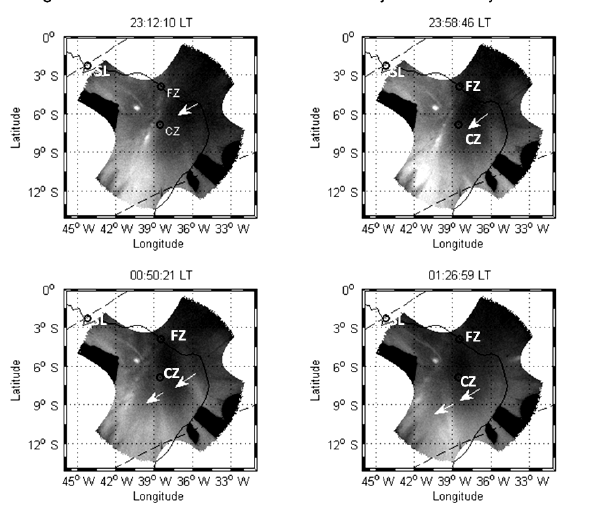
Figure 3. Sequence of OI 630nm images showing the time evolu- tion of depletions on 25–26 July 2011 between 23:12 and 01:26LT at Cajazeiras, Brazil. The images are projected onto geographic co- ordinates over the Brazil map. In the plot, FZ is Fortaleza, SL is São Luís, and CZ is Cajazeiras. Arrows indicate the propagation direction of the depletions (dark regions passing over FZ and